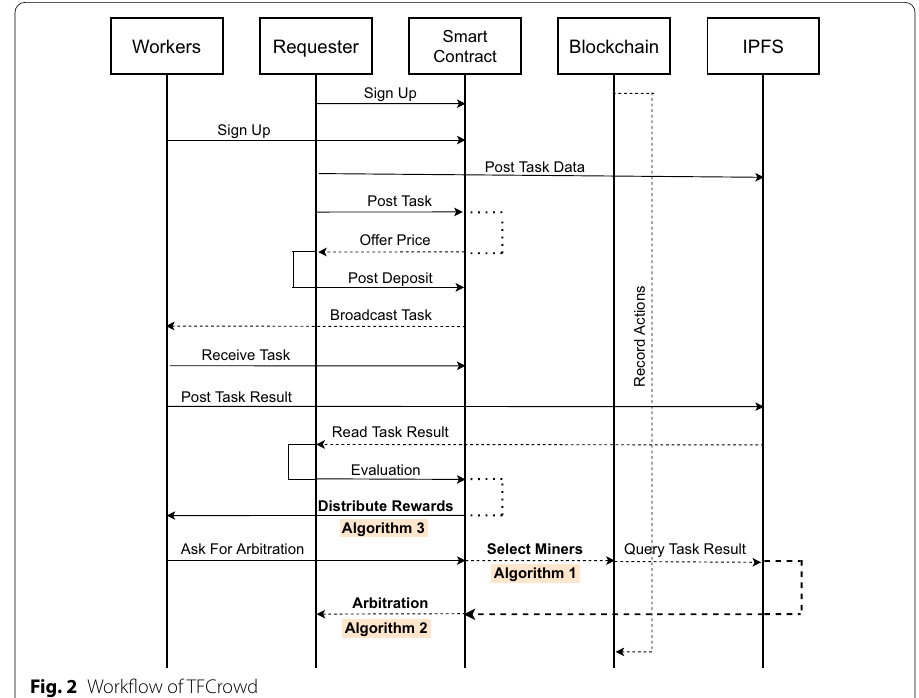
Fig. 2 Workflow of